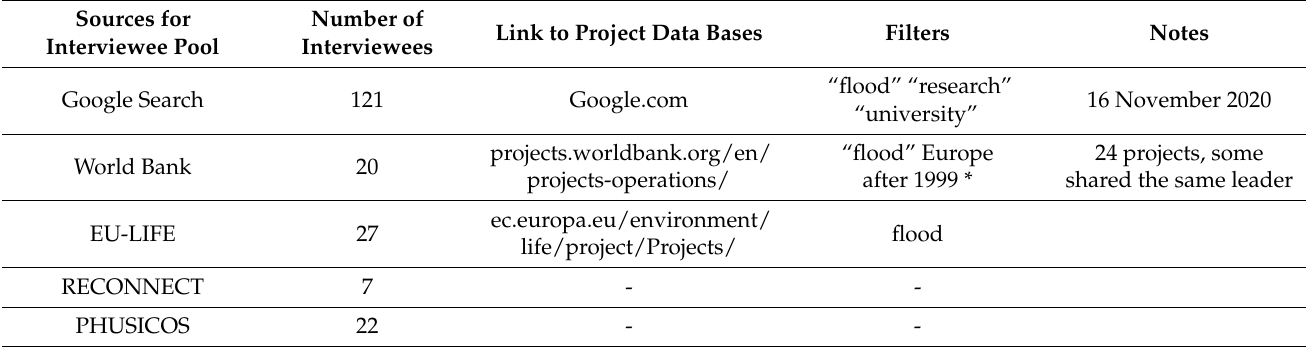
Table 3. List of pools used to identify interviewees for the expert survey. * Projects before 1999 lacked contact information and seemed